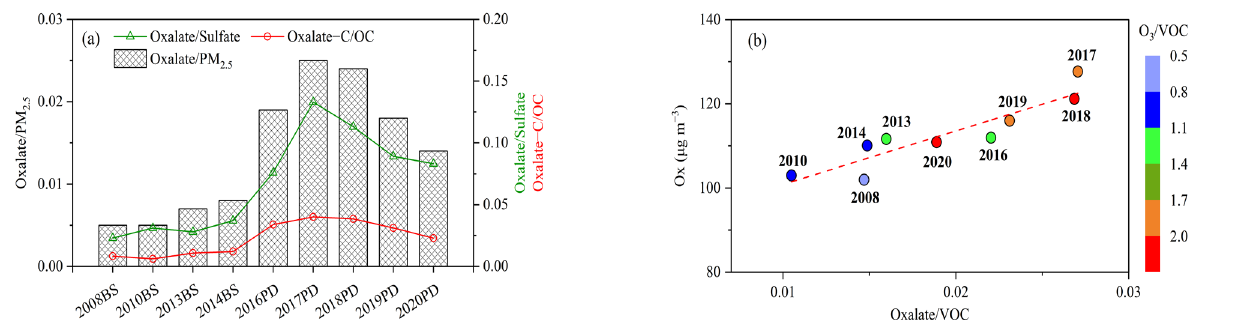
Figure S4: Correlation between oxalate and K + in (a):2008; (b):2010; (c):2013; (d):2014 at the BS site; Figure S5: Correlation between oxalate and K + in (a):2016; (b):2017; (c):2018; (d):2019 at the PD site; Figure S6: Time series of BB contribution to oxalate in BS (a) and PD (b); Figure S7: Clusters of back- ward trajectories for air parcels arriving in Shanghai during 2019; Figure S8: Oxalate correlation with sulfate: (a-i:BS2008-PD2020); Figure S9: Oxalate correlation with SOC (a-g:BS2008-PD2020); Figure S10: Oxalate correlation with SOR (a-g:BS2010-PD2019); Figure S11: Oxalate correlation with NOR for BS (a) and PD(b); Figure S12: (a) RH distribution of oxalate and Ox; (b) RH distribution of oxalate/PM 2.5 and Ox; Figure S13: Oxalate correlation in BS and XJH; Figure S14: Interannual varia- tion of the concentrations of oxalate [54–55]; Figure S15: Evolution of pollutants for Shanghai; Table S1: The ratio of Ca 2+ /K + in biomass burning aerosol reported in previous studies [56–59]; Table S2: Annual PM 2.5 concentrations at 9 monitoring stations in Shanghai during 2015- 2021. Author Contributions: Conceptualization, J.F. and S.W.; Methodology, J.F.; Data curation, J.F. and M.H.; Investigation, N.Z., Y.F. and F.F.; Formal analysis, N.Z. and S.W; writing—original draft prep- aration, N.Z.; writing—review and editing, J.F., S.W. and J.C.; Resources, J.F. and Q.F.; Project ad- ministration, J.F. and Q.F. All authors have read and agreed to the published version of the manu- script.